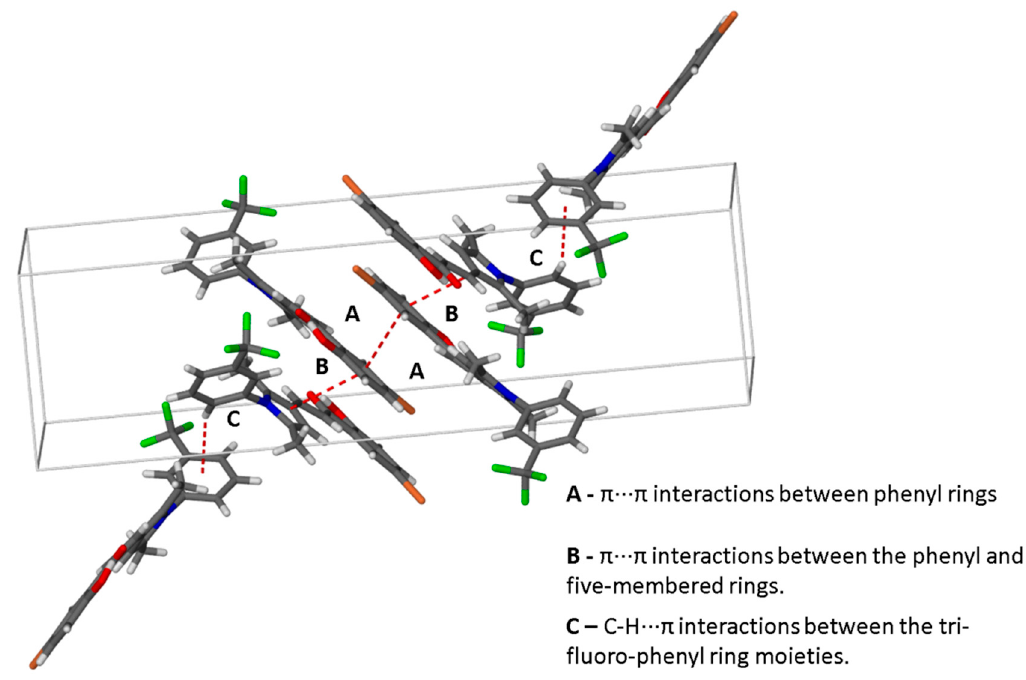
Figure 4. Packing diagram depicting π ··· π stacking and C-H ··· π interactions of 10e that run diagonally across the bc plane. The C-F ··· π interactions have been omitted for clarity.